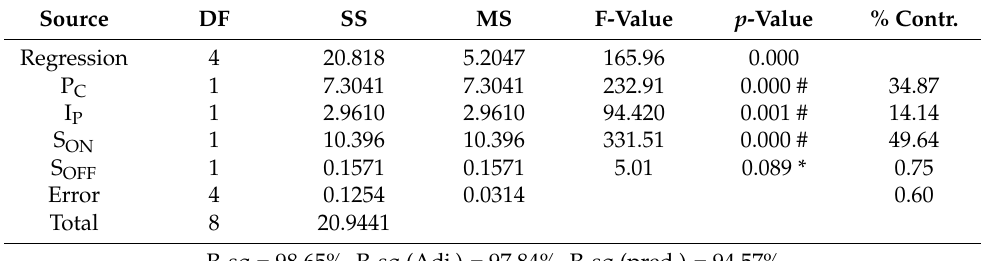
Table 5. ANOVA for